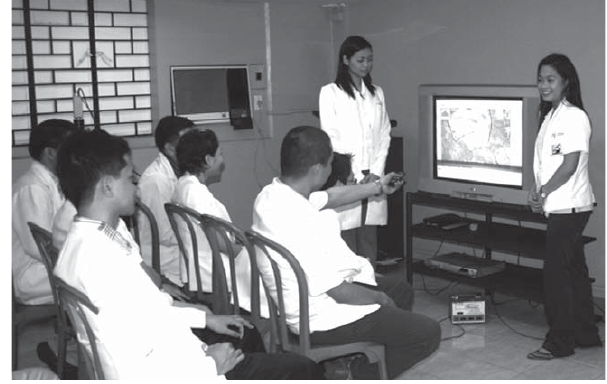
Fig. 2. With digital pathology, teaching, discussion, and student and faculty interaction is